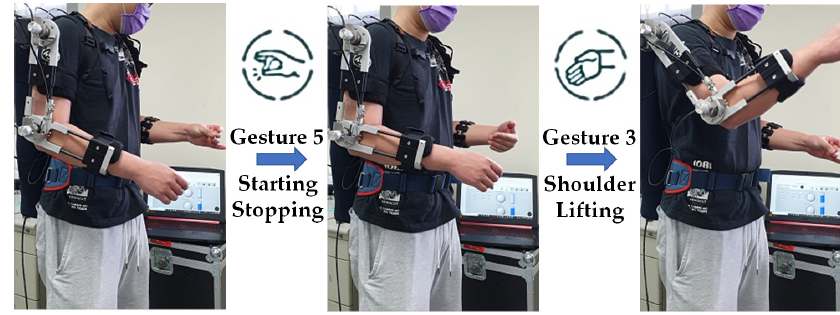
Figure 28. Basic action experiment for elbow lifting.